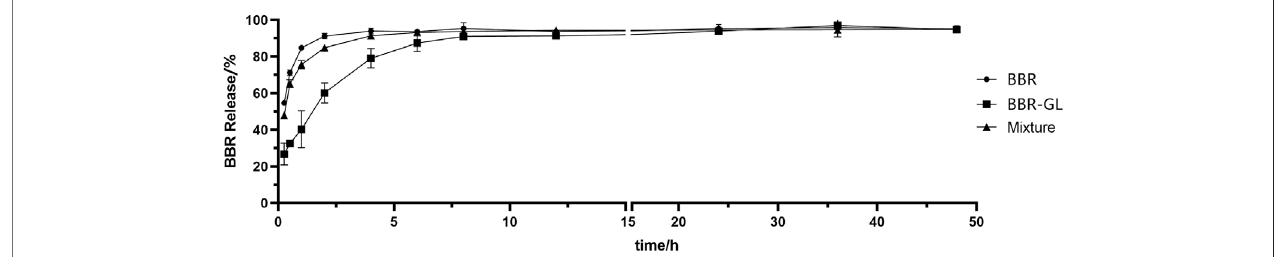
FIGURE 7 | The in vitro drug release curve of BBR, BBR/GL mixture, and BBR-GL complex in pure water. Data are presented as mean ± SD.